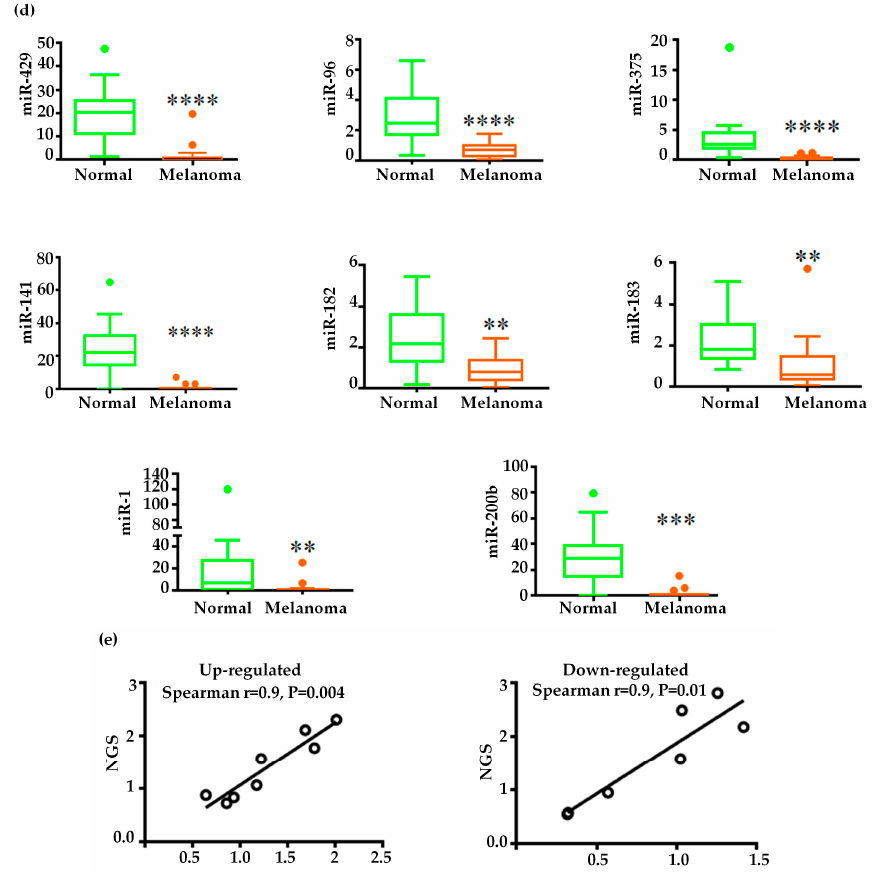
Figure 2. Differential miRNA expression in COM: ( a ) Unsupervised euclidean hierarchical clustering by the miRNA normalized expression values in the normal and melanoma libraries, ( b ) Heatmap visualizes the expression of statistically significant differentially expressed miRNAs in the normal and melanoma libraries. The colour scale (upper right) indicates the expression values. Up- and down-regulated miRNAs are shown in red to green, respectively. Colour saturation indicates the deviation from the median, ( c ) Relative expression of oncogenic miRNAs and ( d ) tumour suppressor miRNAs selected from the next-generation sequencing confirmed by qPCR. The Y-axes indicates the relative miRNA expression levels normalized against RNU6B (normal n = 12, melanoma n = 17, Mann-Whitney test followed by Tukey’s test, * p < 0.05, ** p < 0.01, *** p < 0.001, **** p < 0.0001), ( e ) Correlation of fold change between next-generation sequencing (NGS) and qPCR of the up- and down-regulated miRNAs. Each black circle in the graph represents a